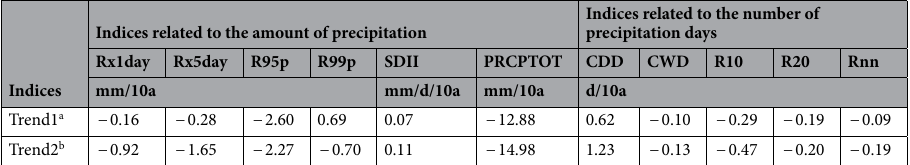
Table 2. Variations of extremes precipitation indices in Shandong from 1961 to 2015. a Trend1 represents the time variation trend of the extreme precipitation indices in this study. b Trend2 represents the time variation trend of the extreme precipitation indices in the coastal areas of Huanghuai, China (including Shandong Province) (Wang 2017).